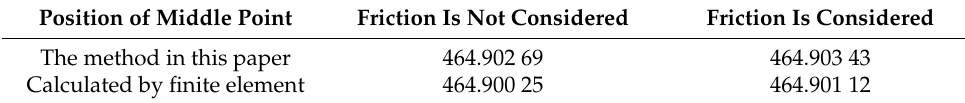
Table 1. Comparison of Calculation Results of Free Cable Shape (Unit: m).